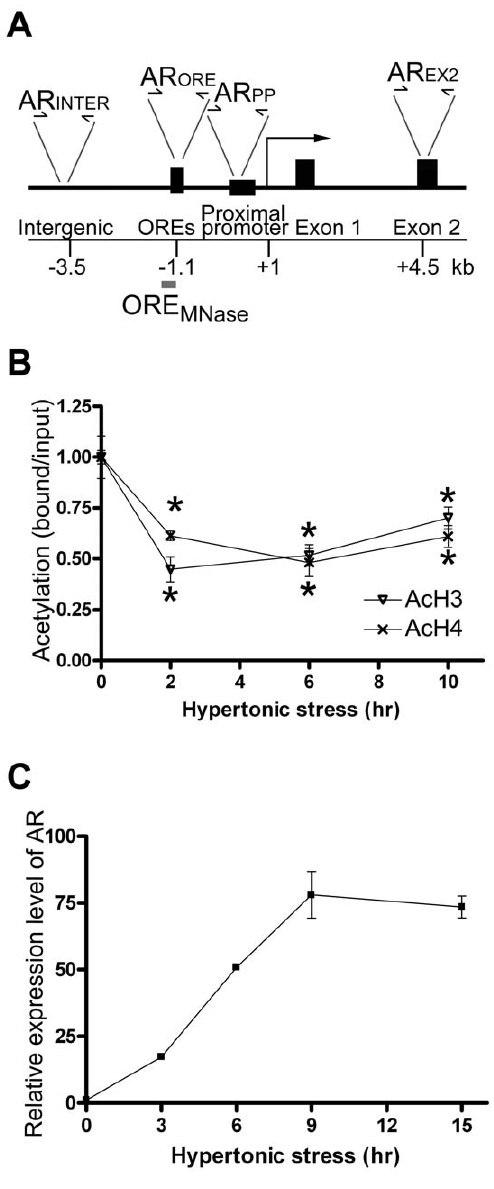
Figure 1. Evaluation of histone acetylation status at the OREs of AR in response to hypertonicity. (A) Schematic illustration of the mouse AR genomic DNA showing exon 1 and 2, promoter and upstream region. The region amplified by primer sets AR INTER , AR ORE , AR PP and AR EX2 are indicated by arrows. Transcriptional start site is indicated by a bold arrow. The DNA probe for southern blotting analysis in the MNase digestion assay (ORE MNase ) is indicated by a grey bar. (B) ChIP assays of AR promoter. ChIP assays were performed with antibodies against acetylated histone H3 or acetylated histone H4 using NIH-3T3 cells that were induced with hypertonicity for 0, 2, 6 and 10 h, respectively. DNA was analyzed by real-time PCR using AR ORE primer pair. The results are normalized to the ratio of immunoprecip- itated DNA to total input DNA at time 0. Data are the mean 6 SEM (n=3). *, p , 0.05 by one-way ANOVA test when compared to the value at time 0. (C) Quantitative analysis of AR transcriptions by RT-PCR. NIH- 3T3 cells were incubated in hypertonic medium for 0, 3, 6, 8 and 15